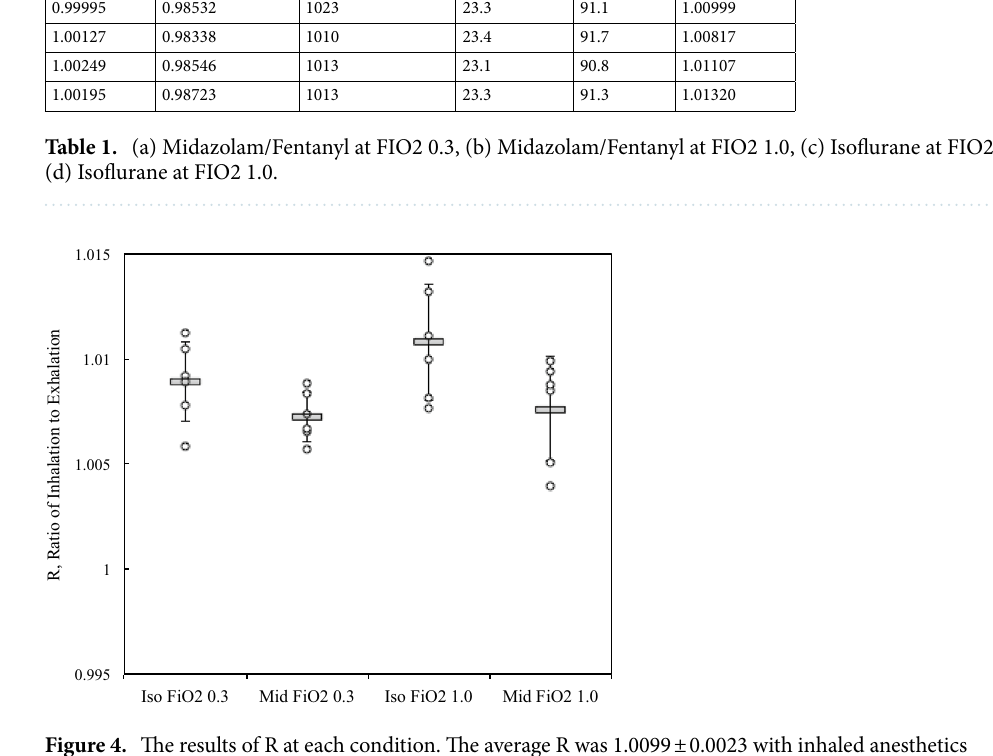
Figure 4. The results of R at each condition. The average R was 1.0099 ± 0.0023 with inhaled anesthetics (isoflurane), and it was 1.0074 ± 0.0018 with intravenous anesthetics (midazolam plus fentanyl). The average R was 1.0081 ± 0.0017 at an FIO2 of 0.3 and it was 1.0092 ± 0.0029 at an FIO2 of 1.0. There were no significant differences in the number of R from either anesthetics or